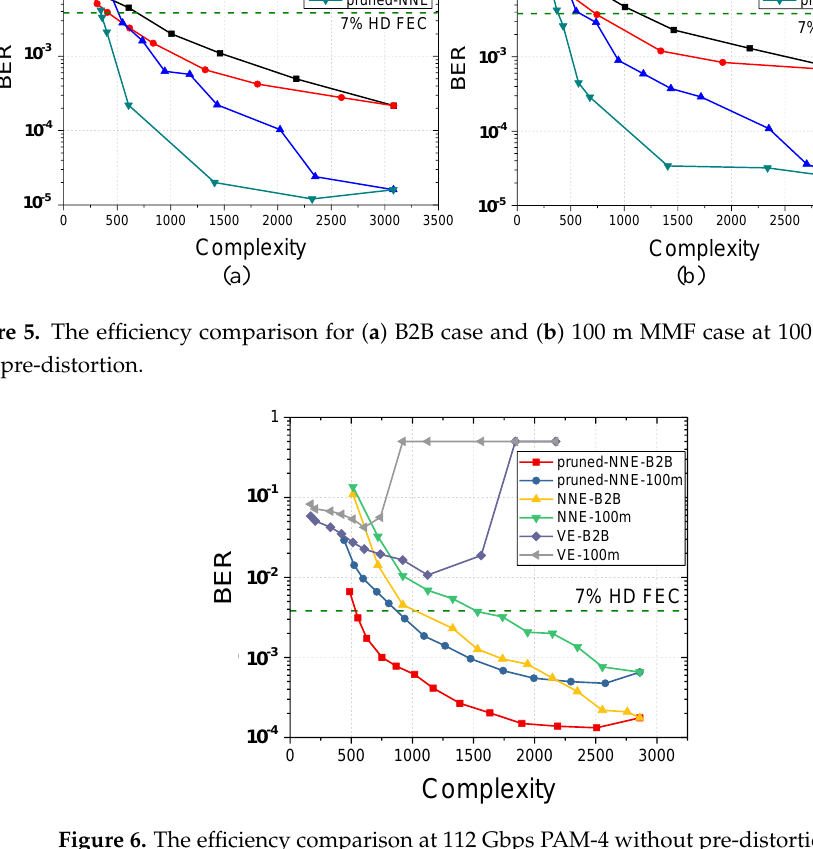
Figure 6. The efficiency comparison at 112 Gbps PAM-4 without